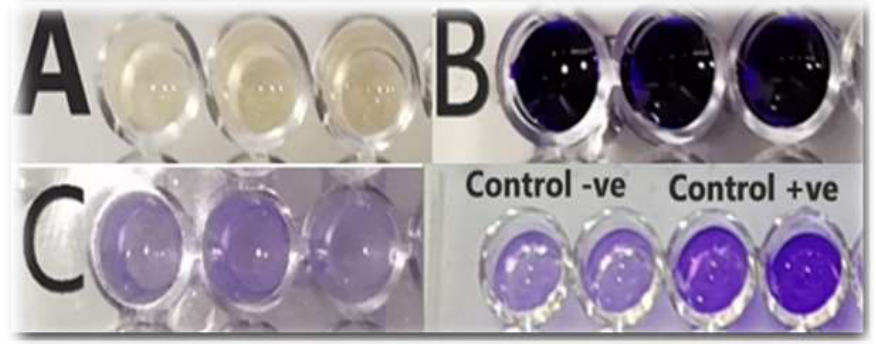
Figure 4: Anti-biofilm Efficacy of Tea Tree Oil against K. pneumoniae Isolates by Tissue Culture Plate Method (A) After 24 hours of incubation at 37°C, (B) During staining with 1% crystal violet, and (C) After dissolving adherent cells in 95% ethanol. The Negative Control Consists of (MIC value with TSBG) While the positive control consists of (Bacterial sample with TSBG).